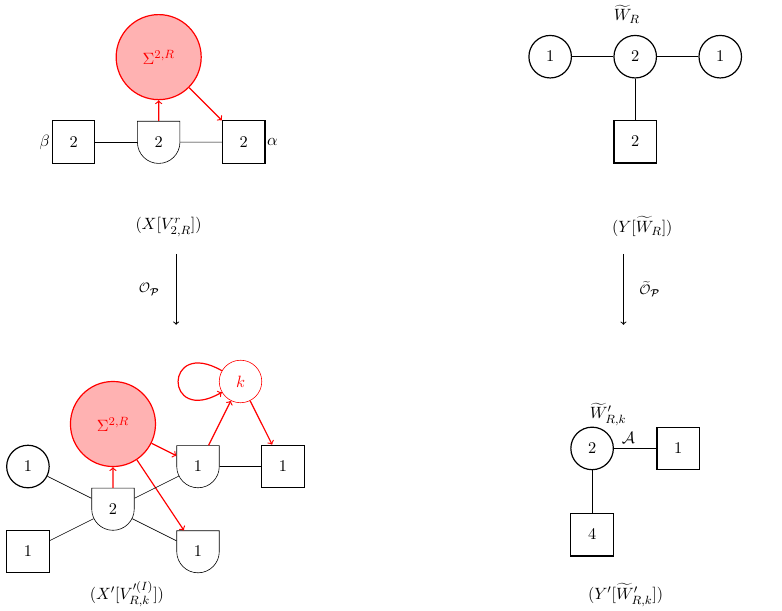
Figure 52 . Construction of a 3d-1d system which realizes a vortex defect in the flavored D 4 quiver and the dual Wilson defect in the mirror U(2) gauge theory, using an Abelian S -type operation O The S -type operation, in this case, involves a Type-A defect